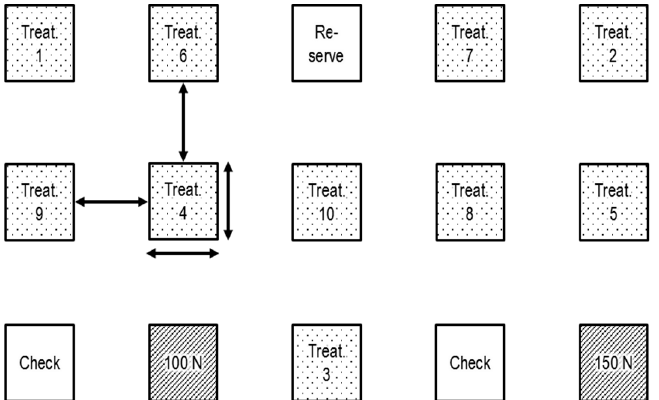
Figure 1. Experimental design of one block, used for multi ‐ plot NH 3 loss measurements with pas ‐ sive samplers by square treatment plots (9 m × 9 m), Plots were separated by 9 m non ‐ fertilised buffers. Treat. = treatment; Check = control plot with background measurement; 100/150 N = 100/150 kg N ha − 1 synthetic CAN fertilizer; arrows = 9 m distance .